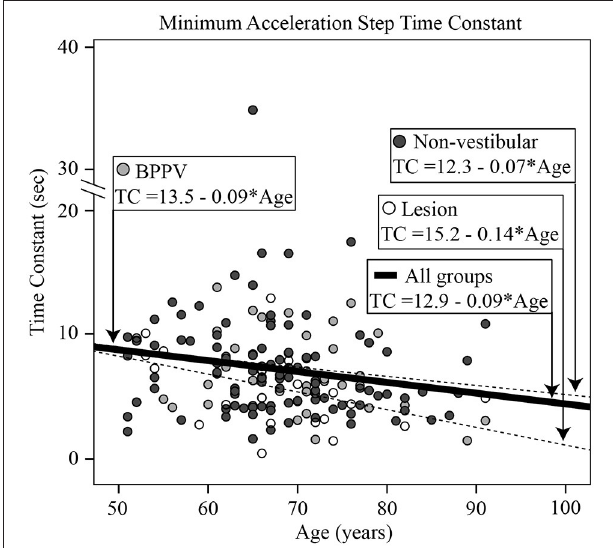
FIGURE 6 | Histogram of the minimum acceleration step time constant [across all directions and stimuli [left excitatory, left inhibitory, right excitatory, right inhibitory]] for each participant vs. their age, clustered by group with group and overall line-fits.